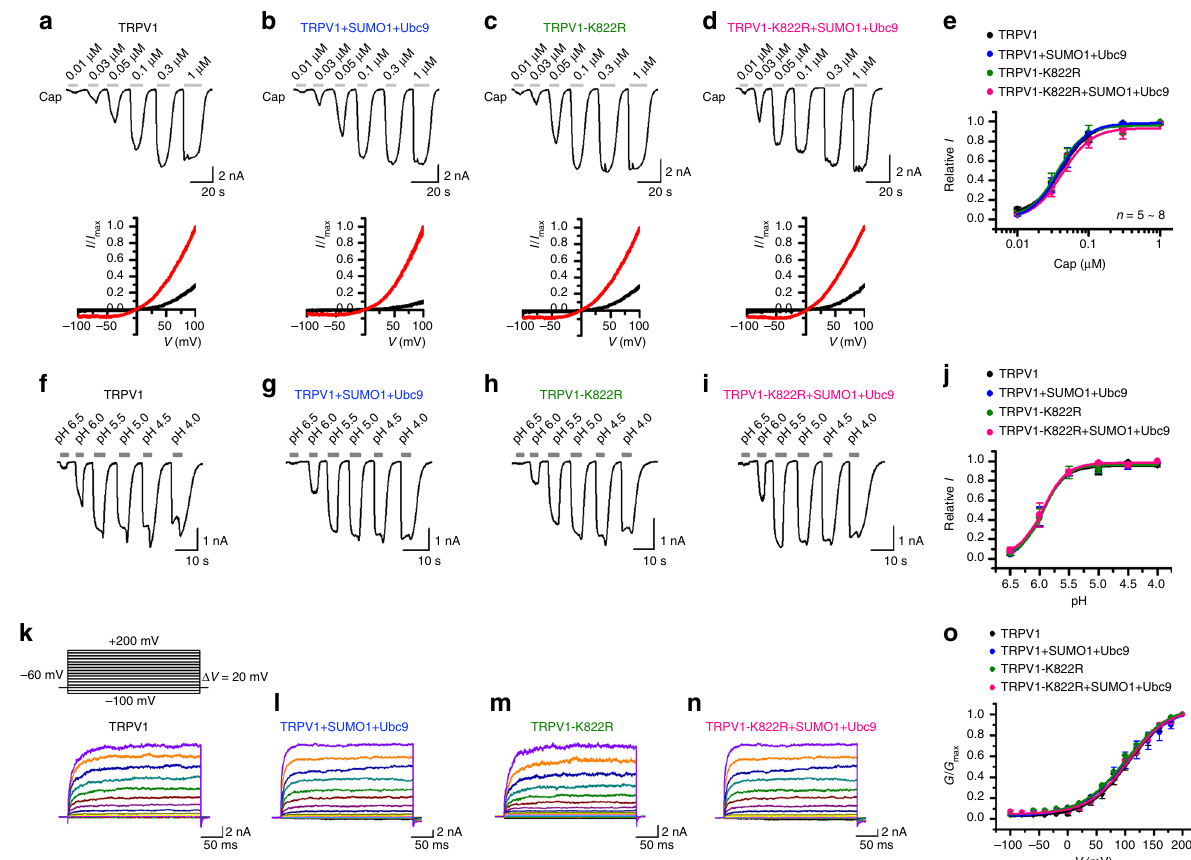
Fig. 6 SUMOylation had no effect on capsaicin-, proton- and voltage-dependent activation of TRPV1 channels. a , b Representative traces for currents at − 60 mV evoked by increasing concentrations of capsaicin (Cap) as indicated for CHO-K1 cells that expressed Flag-tagged rat TRPV1 (Flag-TRPV1) ( a ), Flag-TRPV1 + GFP-SUMO1 + Ubc9 ( b ), Flag-TRPV1-K822R ( c ), and Flag-TRPV1-K822R + GFP-SUMO1 + Ubc9 ( d ). The current – voltage relationships shown below the traces are for basal (black) and 0.03 µ M capsaicin-stimulated (red) conditions. e Concentration – response curves for capsaicin-evoked currents. Solid lines indicate fi ts with the Hill equation. Data points are means ± s.e.m., with n = 8 for TRPV1 (black); n = 6 for TRPV1 + SUMO1 + Ubc9 (blue); n = 6 for TRPV1-K822R (olive); n = 6 for TRPV1-K822R + SUMO1 + Ubc9 (pink). f – i Representative traces for currents at − 60 mV evoked by solutions with decreasing pH values as indicated for CHO-K1 cells that expressed Flag-TRPV1 ( f ), Flag-TRPV1 + GFP-SUMO1 + Ubc9 ( g ), Flag-TRPV1-K822R ( h ), and Flag- TRPV1-K822R + GFP-SUMO1 + Ubc9 ( i ). j Concentration – response curves for proton-evoked currents. Solid lines indicate fi ts with the Hill equation. Data points are means ± s.e.m., with n = 7 for TRPV1 (black); n = 9 for TRPV1 + SUMO1 + Ubc9 (blue); n = 7 for TRPV1-K822R (olive); n = 7 for TRPV1 K822R + SUMO1 + Ubc9 (pink). k – n Representative traces of currents evoked by a family of voltage steps from − 100 to + 200 mV with 20 mV increments as shown in inset in k for CHO-K1 cells that expressed Flag-TRPV1 ( k ), Flag-TRPV1 + GFP-SUMO1 + Ubc9 ( l ), Flag-TRPV1-K822R ( m ), and Flag-TRPV1-K822R + GFP-SUMO1 + Ubc9 ( n ). Holding potential was − 60 mV. o Conductance – voltage ( G – V ) relationships derived from the experiments shown in k – m fi tted with the Boltzmann function, which yielded the following results: for TRPV1 (black), V 1/2 = 105.8 ± 2.2 mV, and κ = 35.5 ± 1.9 ( n = 7); TRPV1 + SUMO1 + Ubc9 (blue), V = 101.5 ± 4.2 mV, and κ = 40.2 ± 3.7 ( n = 7); TRPV1-K822R (olive), V = 101.3 ± 3.7 mV, and κ = 38.9 ± 1.7 ( n = 7); and TRPV1-K822R 1/2 1/2 + SUMO1 + Ubc9 (pink), V = 104.8± 1.5 mV, and κ = 35.1 ± 1.3 ( n = 5). Data points are means ± 1/2